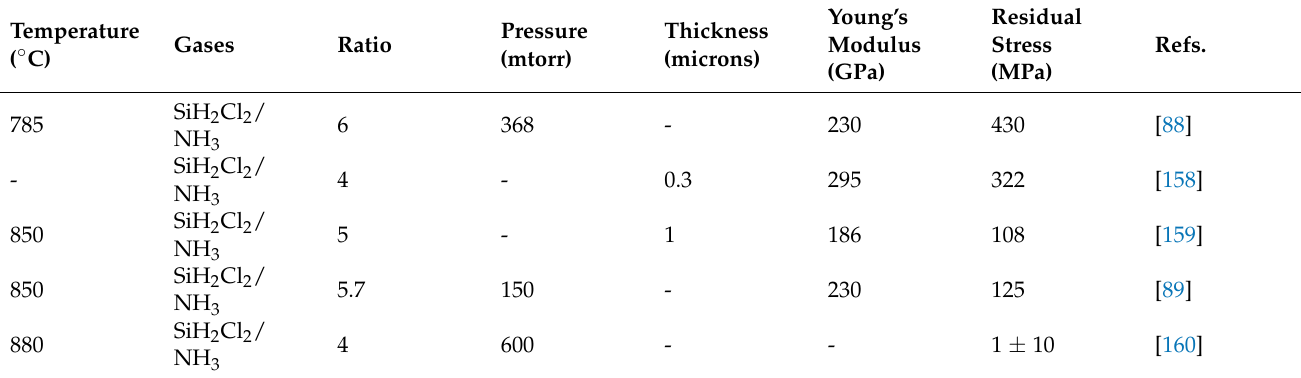
Table 23. Residual Stress Values of as-deposited LPCVD SiN thin-films